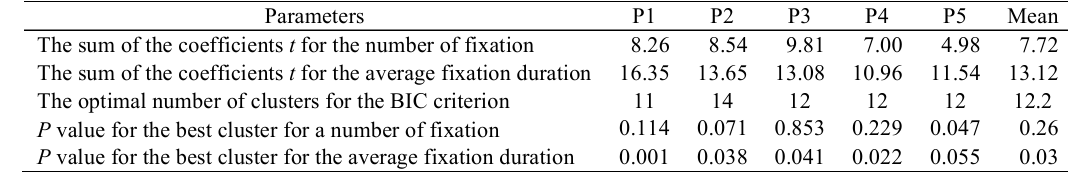
Table 9. T-values, p-values and optimum number of clusters for the BIC criteria. The sum of the coefficients t for the number of fixation The sum of the coefficients t for the average fixation duration The optimal number of clusters for the BIC criterion P value for the best cluster for a number of fixation P value for the best cluster for the average fixation duration